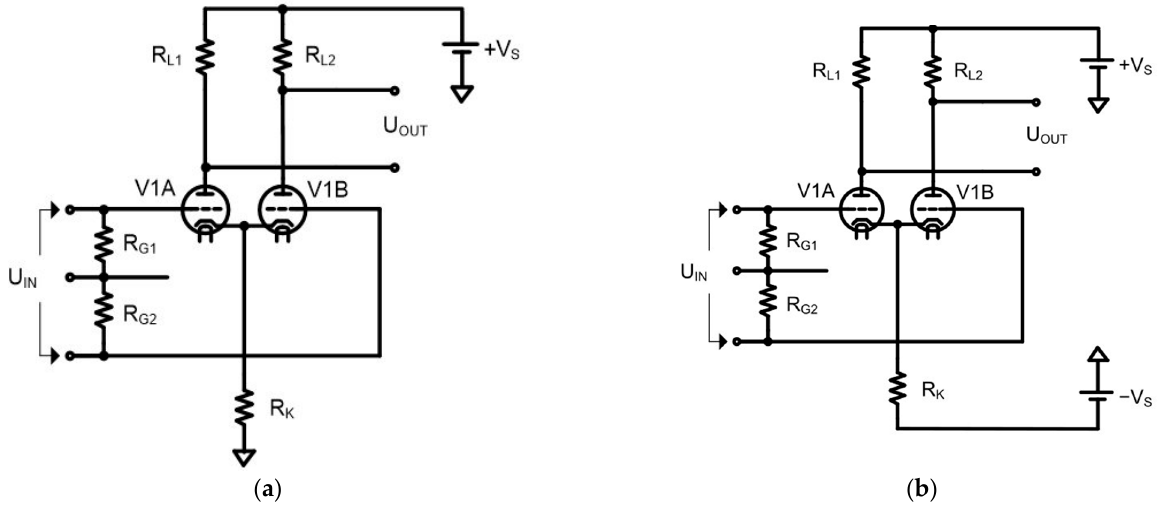
Figure 3. Schematics of Matthews ( a ) and Blumlein ( b ) differential amplifiers.